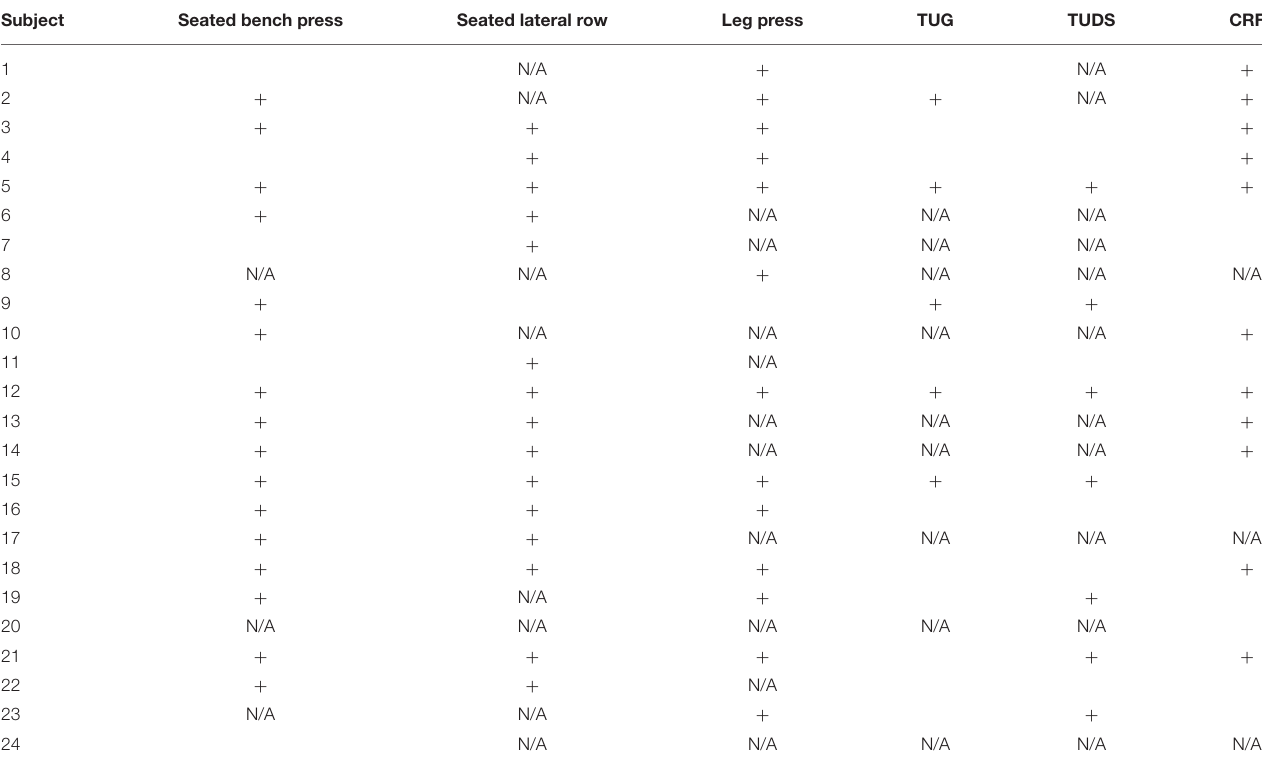
TABLE 3 | Individual response to the different performance tests.